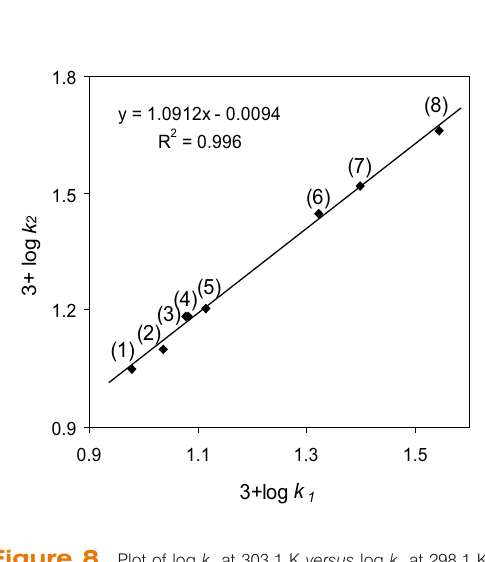
Figure 8. Plot of log k versus log k 2 at 303.1 K 1 at 298.1 K for the Isokinetic temperature (Table 1) (1) L-Glutamic acid;